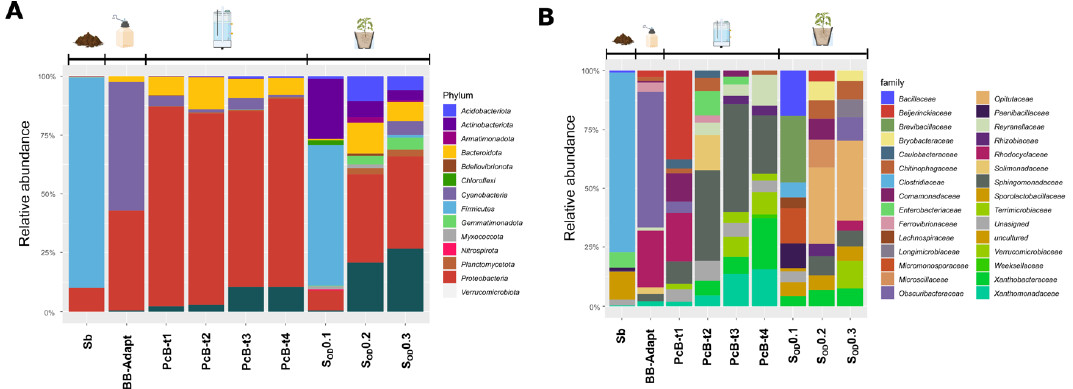
Figure 3. Complete progressive microbial changes in the relative abundance of bacteria along with the experiment: ( A ) Phylum and ( B ) Family. Sb: Bare soil; BB: batch bioreactor; PcB: Packed Biore- actor; S OD : Rhizospheric soil after application of microbial solution; numbers mean bacterial OD